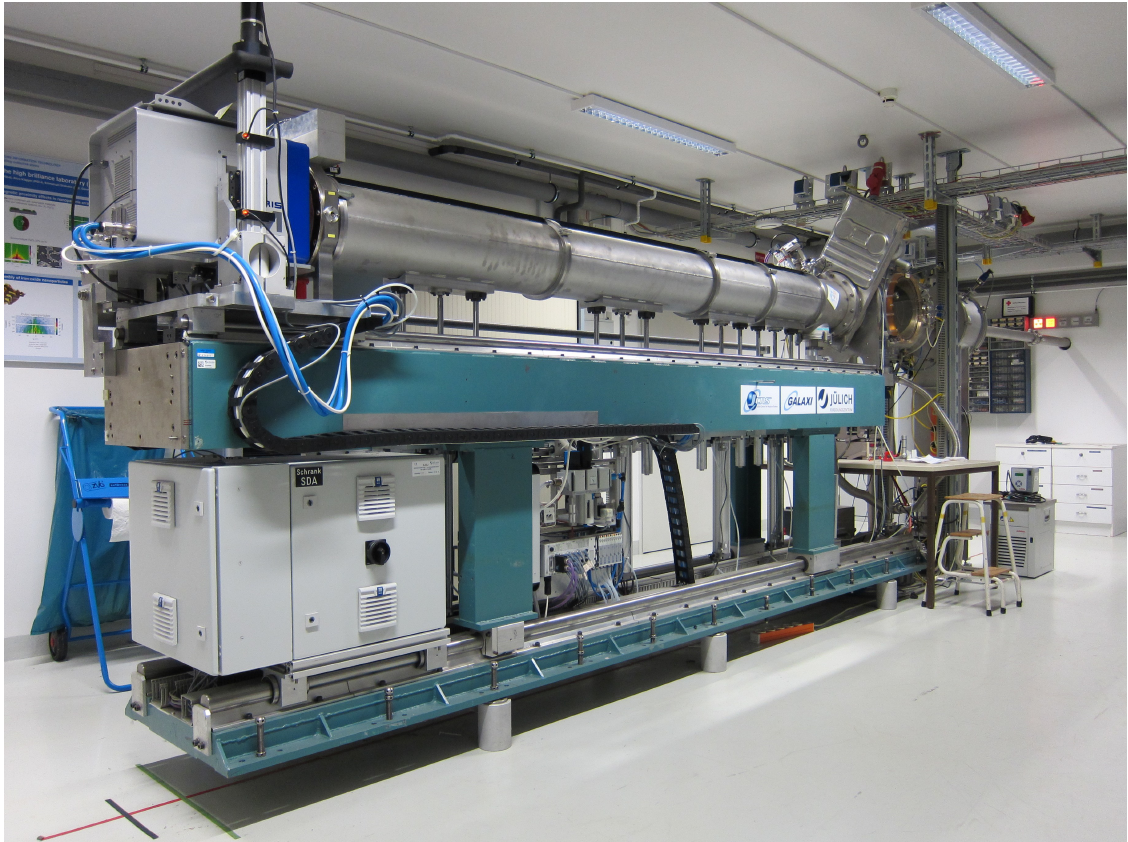
Figure 2: GALAXI diffractometer with the longest detector distance available. The X-ray source is located behind the wall, the detector is at the left hand